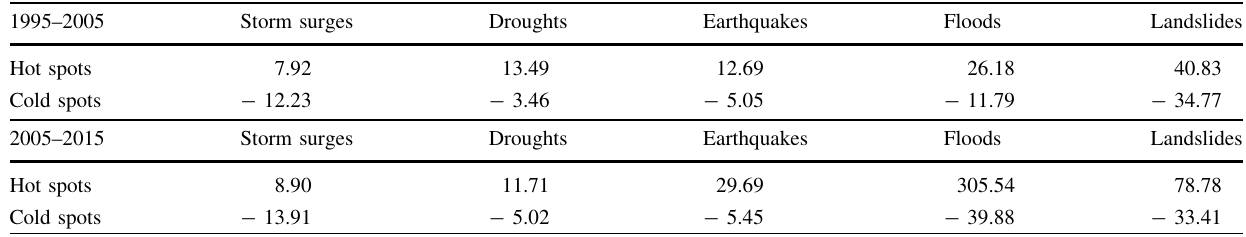
Table 6 Hot/cold spots of changes (%) in cropland exposure to different hazards in China from 1995 to 2015